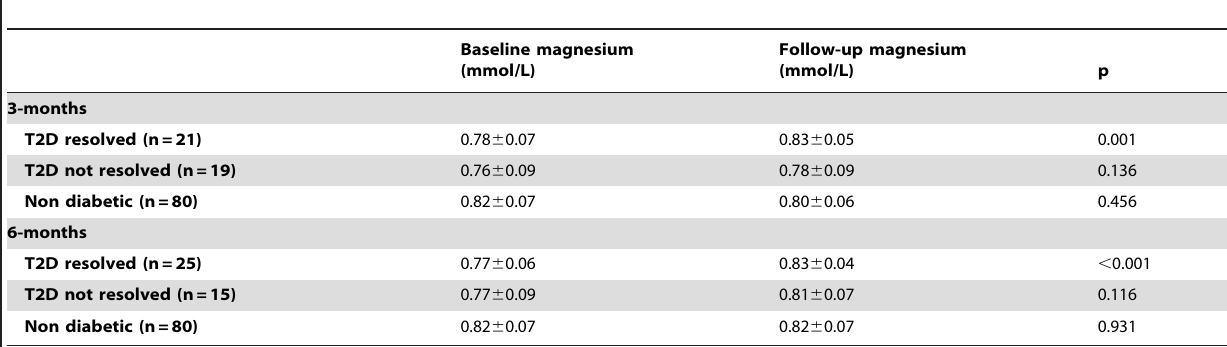
Table 3. Three and 6-months evolution after RYGBP of serum magnesium concentrations in non-diabetic subjects, and both type 2 diabetic obese patients who resolve and not resolve their